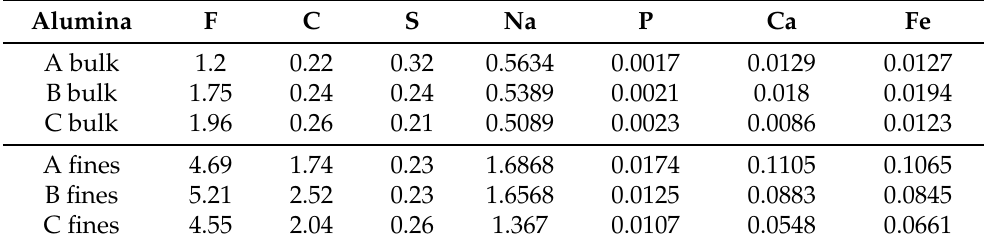
Table 2. The content in wt% of the different elements found in alumina samples.